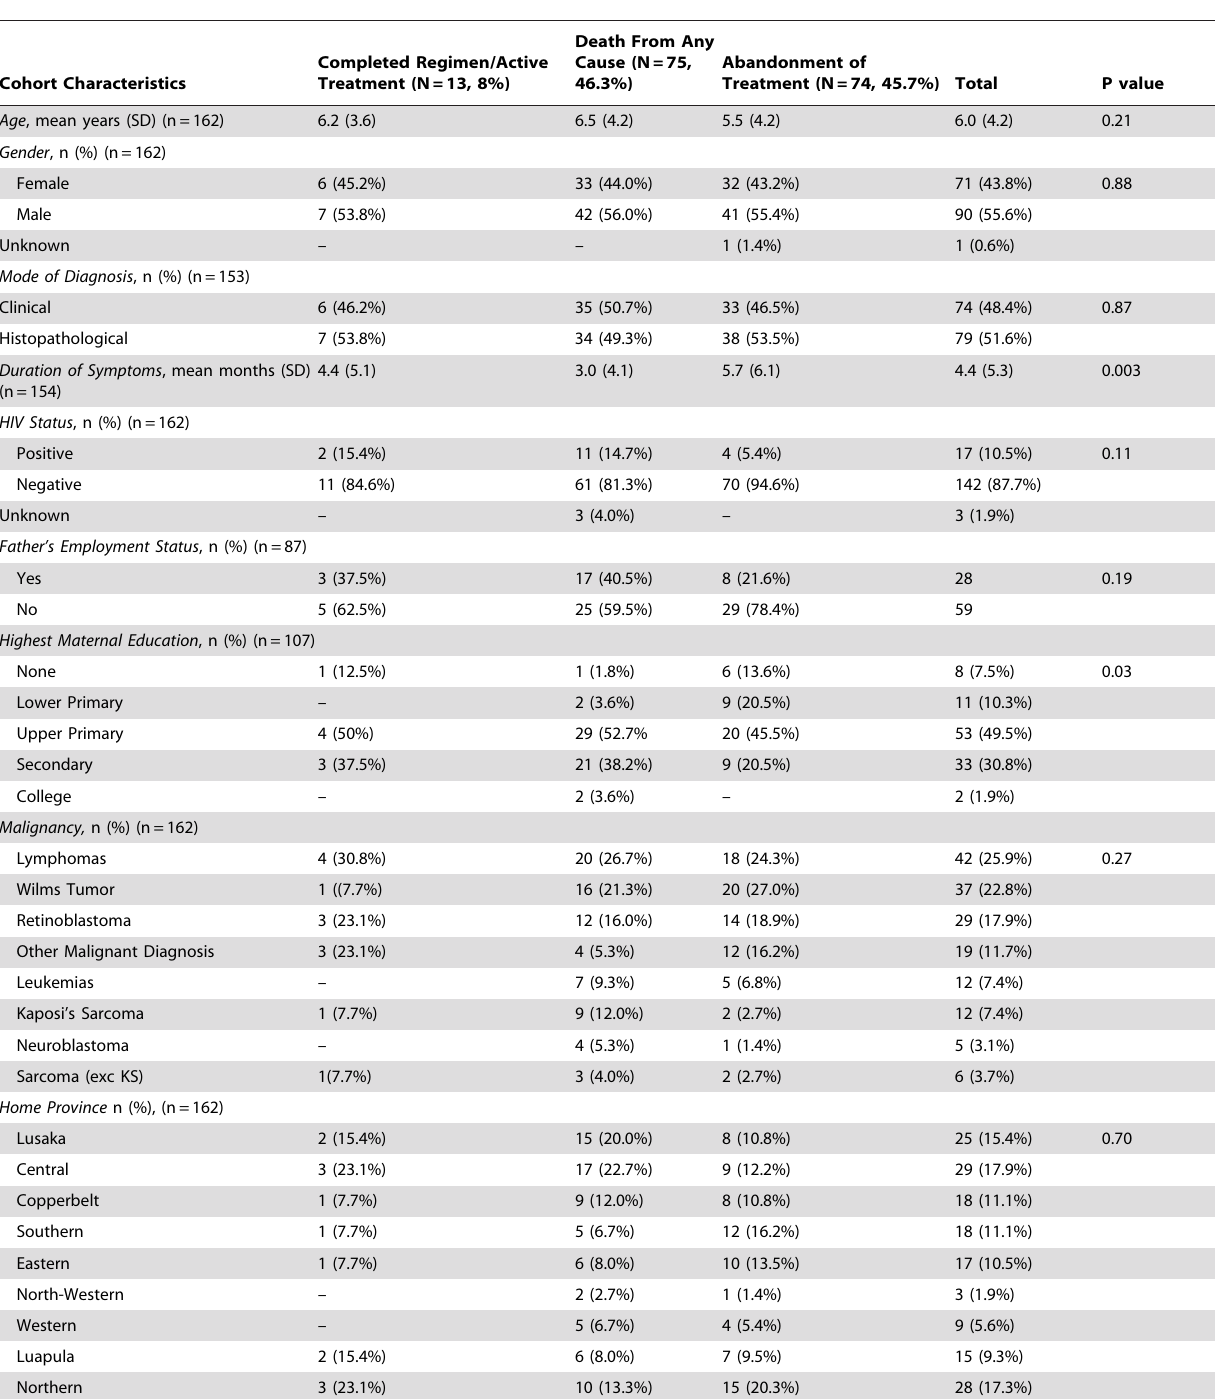
Table 1. Cohort Characteristics for 162 children with cancer seen at the University Teaching Hospital, Lusaka, Zambia*.